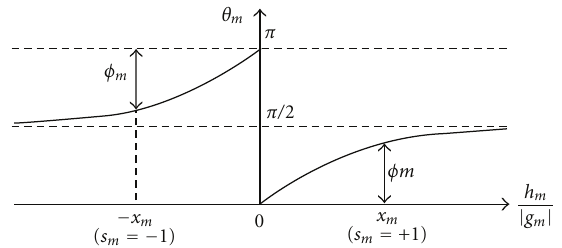
Figure 3: Illustration of the phase angles θ m and φ m for representing the Fresnel reflection coe ffi cient in the exponential form r m =